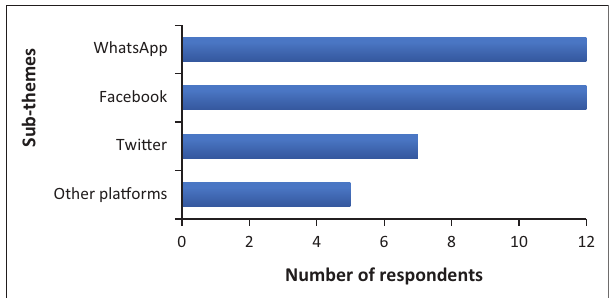
FIG URE 5: Theme 3